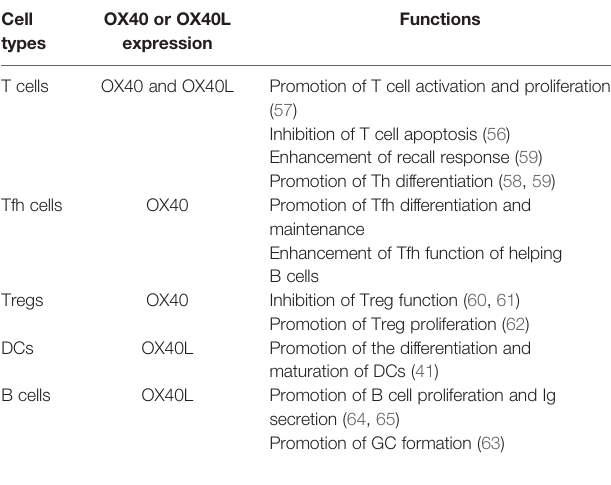
TABLE 1 | OX40/OX40L functions in different cell